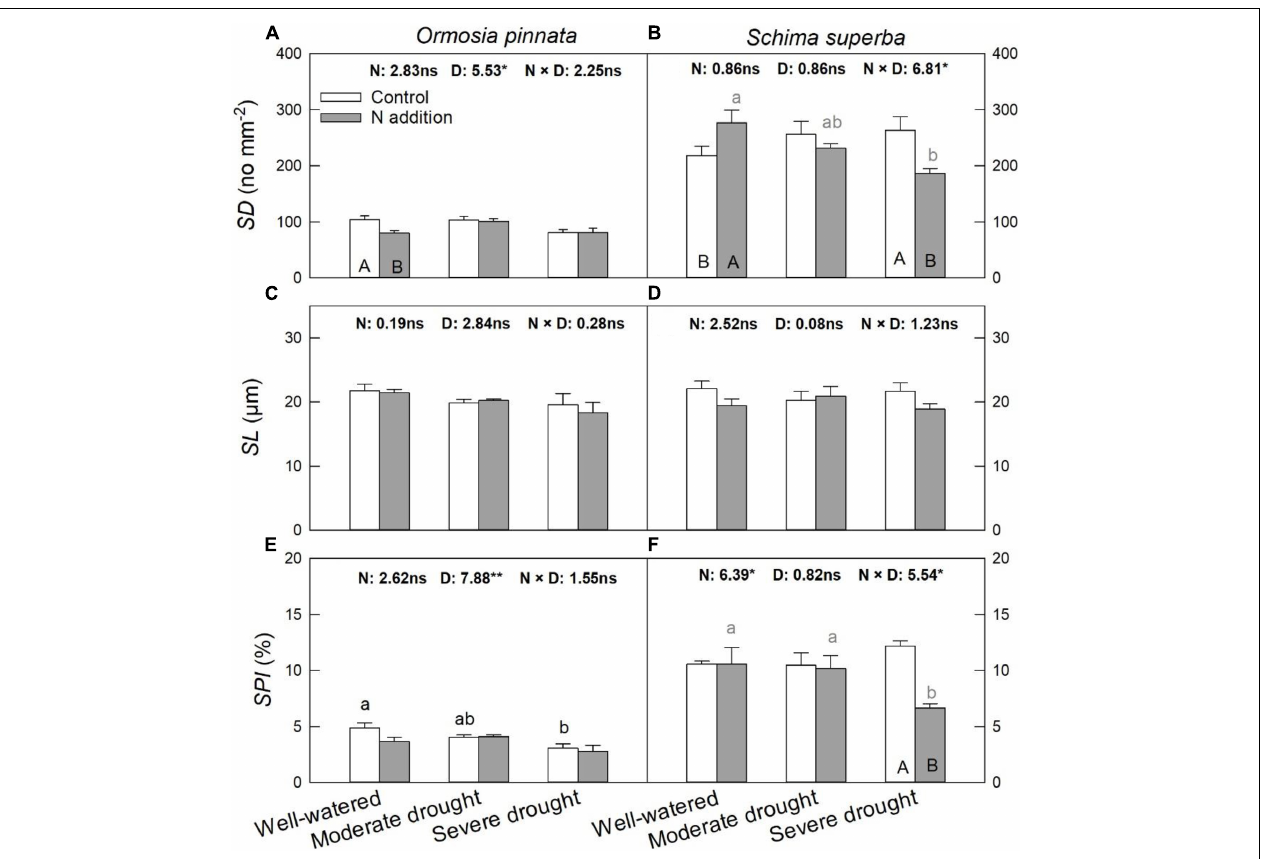
FIGURE 6 | Responses of stomatal density ( SD ; A,B ), stomatal length ( SL ; C,D ), and stomatal pore index ( SPI ; E,F ) of O. pinnata and S. superba to different watering and N addition treatments. Bars show means ± SE ( n = 3). Different lowercase letters above bars indicate significant differences among three watering regimes within each N addition rate. Different capitalized letters below bars indicate significant differences between control and N addition within each watering regime. F -values of the two-way ANOVA of nitrogen (N), drought (D), and their interactions (N × D) are indicated. * P < 0.05; ** P < 0.01; ns, not